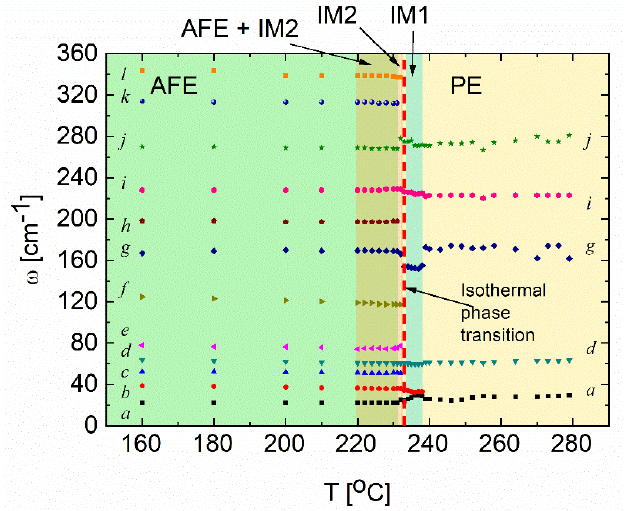
Figure 4. Temperature dependence of Raman frequencies for PbZrO 3 :0.1Nb crystal. The dotted line corresponds to the isothermal transition point (the red dashed line points to the 233 °C at which the time evolution is presented in Figure 5). The colored regions correspond to transitions at T PE-IM1 and T IM2-AFE detected in the permittivity and optical measurements [23].